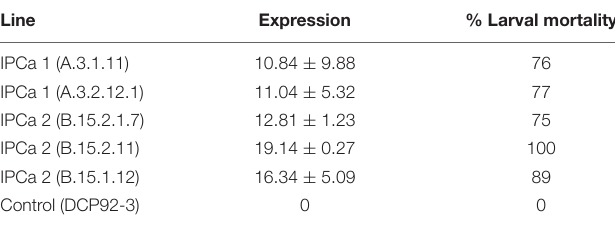
TABLE 3 | Correlation between efficacy and the amount of Insecticidal Cry protein in leaf